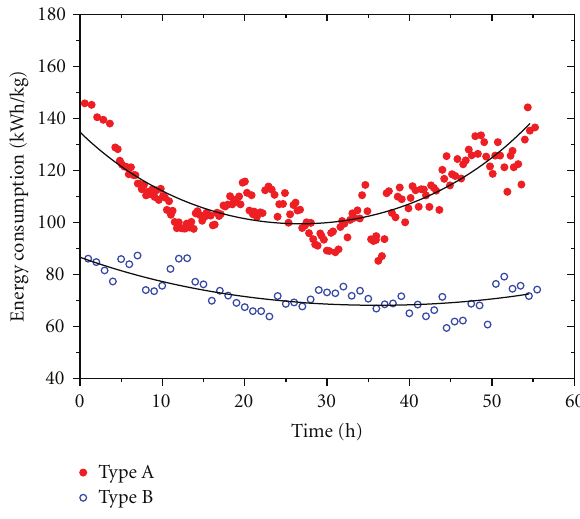
Figure 6: Thickness variation of 4 poly-Si rod along the height. Figure 7: Power consumption throughout the deposition